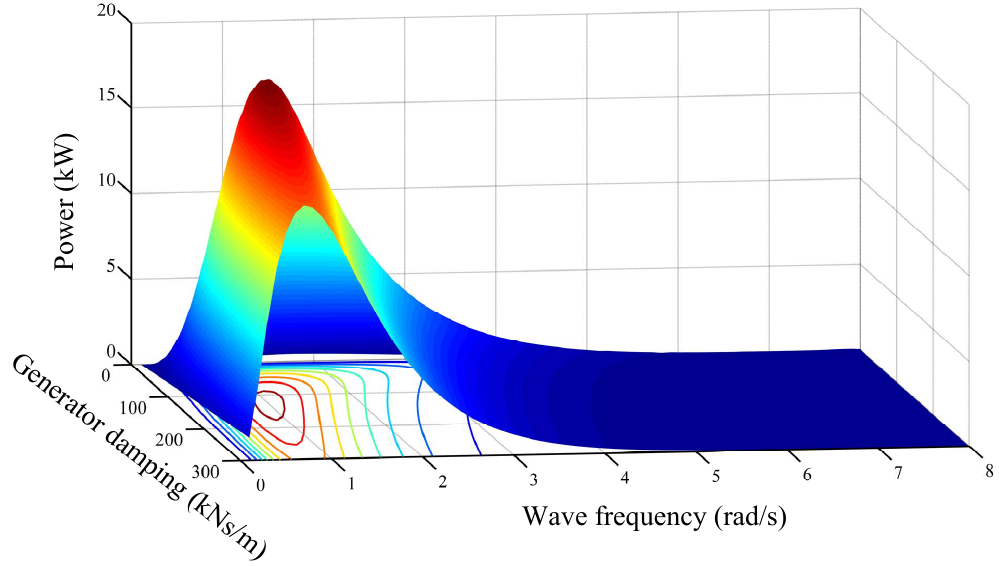
Wave frequency (rad/s)